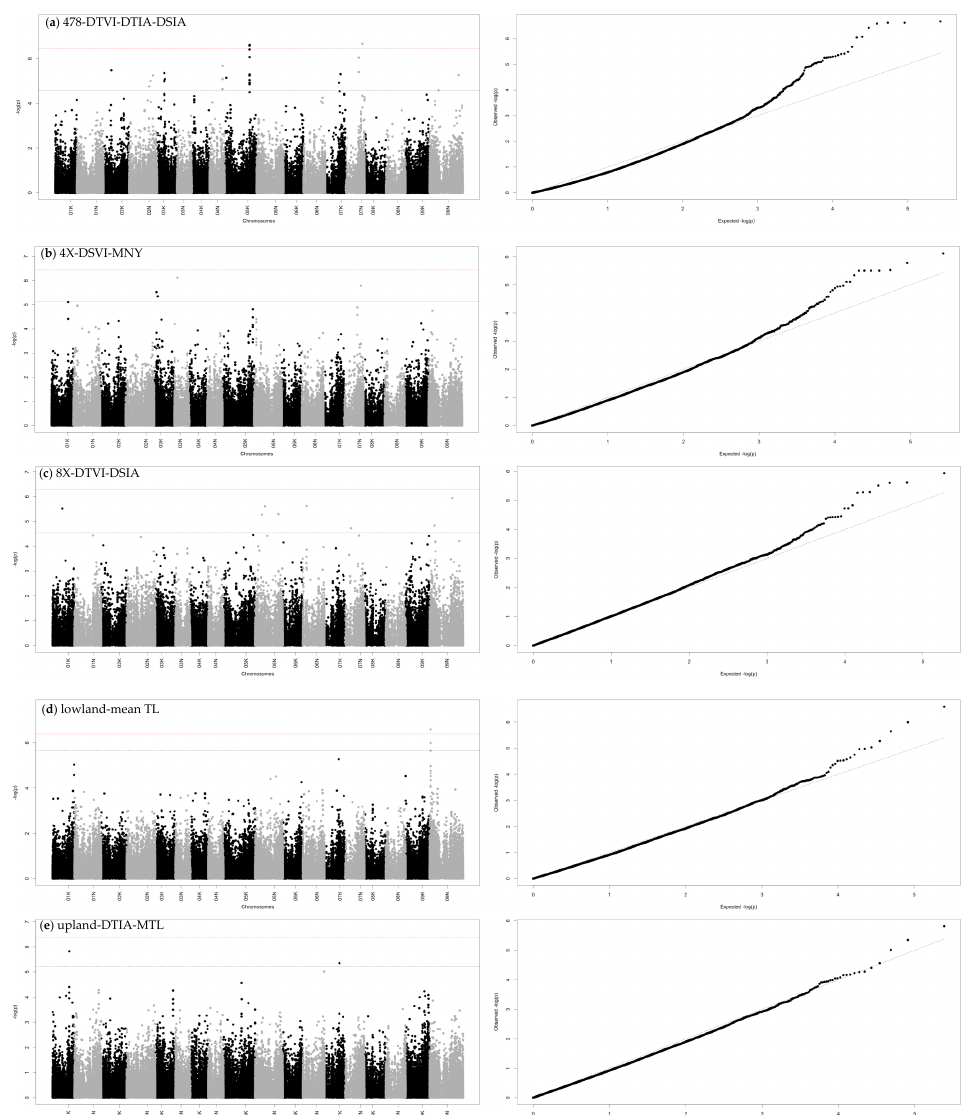
Figure 4. ( Left ) Manhattan plot showed genetic association of ( a ) DTVI-DTIA-DSIA in 478 genotypes, ( b ) DSVI-MNY in 4X genotypes, ( c ) DTVI-DSIA in 8X genotypes, ( d ) mean TL in lowland genotypes, ( e ) DTIA-MTL in upland genotypes. The black dashed line represented the FDR threshold (0.1), and the red dashed line represented the Bonferroni correction threshold. On the x-axis, the physical positions of the SNPs were aligned in 18 chromosomes of P. virgatum. (Right) Quantile-quantile (QQ) plots between the distributions of observed to expected p -values for GWAS of each trait combination in each genotype group. Abbrevia- tions: BLUPs of severity from the detached leaf via vision (DTVI), BLUPs of severity from the detached leaf via image analysis (DTIA), BLUPs of severity from the leaf disk assay via vision (DSVI), BLUPs of severity from the leaf disk assay via image analysis (DSIA), mean of field evaluation of BLS in two locations (mean TL), the highest score of BLS in NY (MNY), and the highest score of BLS in the two locations (MTL).